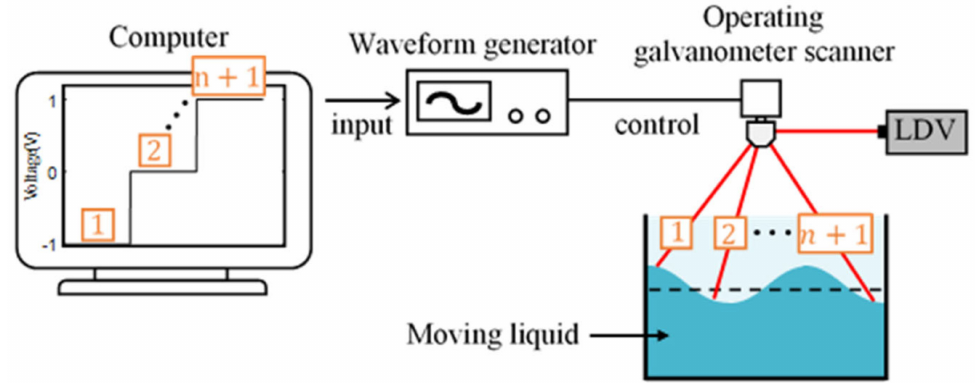
Figure 5. Operation of the stepwise rotating galvanometer (n: number of steps). After the measurement is completed, the multipoint data obtained through the gal- vanometer scanner rotating with the step function are separated from each other at the same position to form a single point of time-series data. The constant rotation frequency of the galvanometer scanner is the measurement frequency of the separated time-series data. Due to the characteristic of the step function, spike noise is generated in addition to the data that occurs in the stable section following the generation of the spike